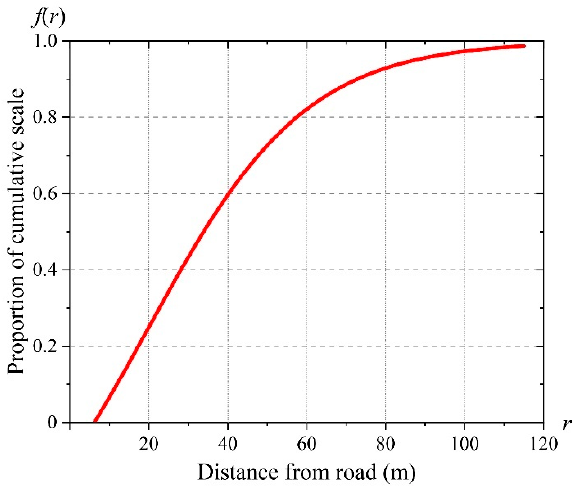
Figure 5. The graph of rural settlement scale growth function.